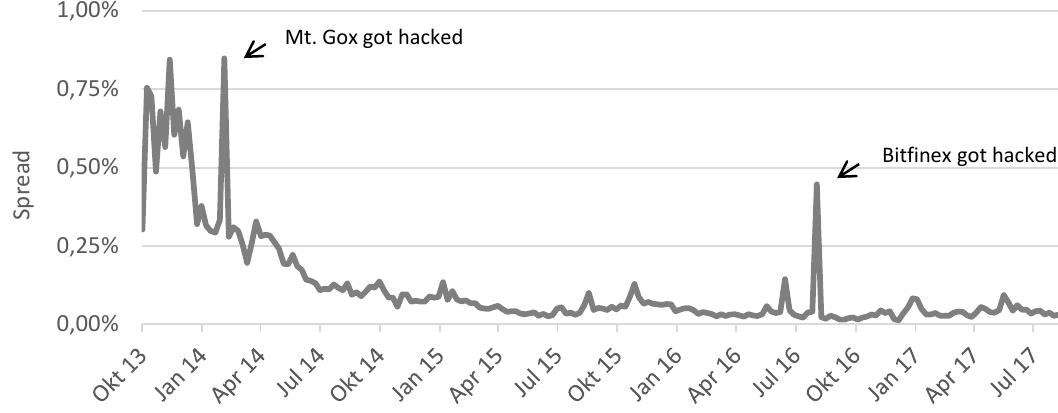
Figure 4. Bid-ask spread of Bitcoin on the Bitfinex exchange, weekly